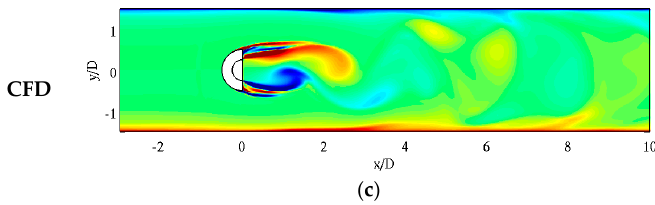
Figure 7. Vertical vorticity component ( t = 86.5 s) at ( a ) z / D = − 0.5; ( b ) z / D = 0.5; and ( c ) z / D = 0.0 along with the experimental visualization for z/D = − 0.5 and z / D = 0.5.